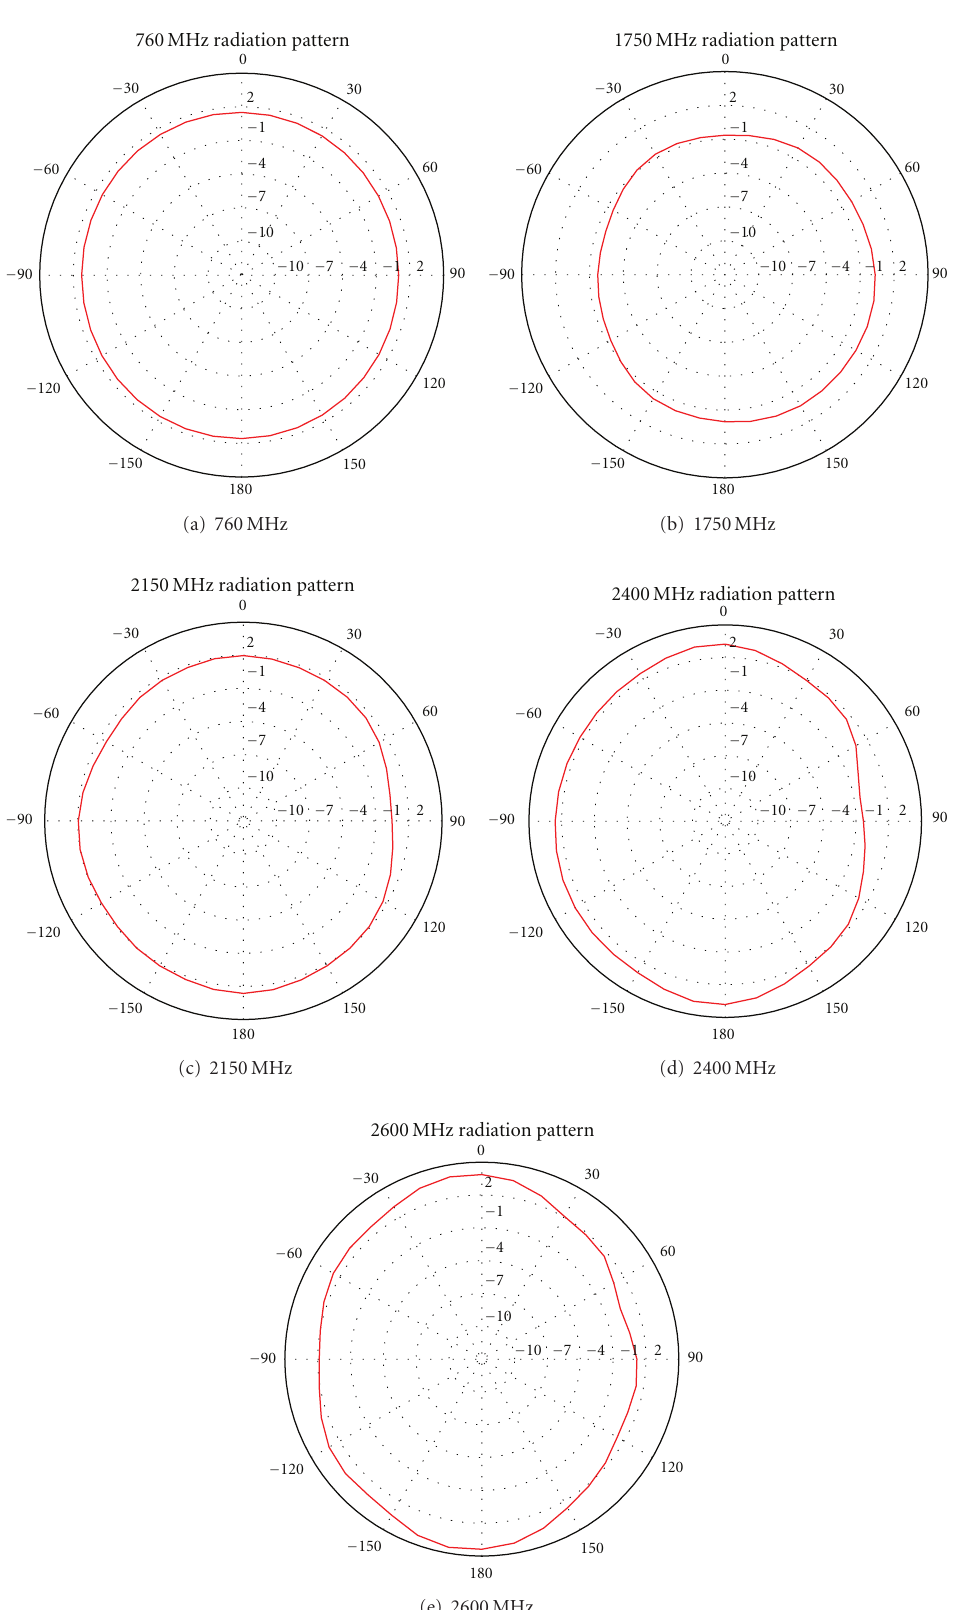
Figure 8: Radiation patterns of antenna 1 in x - z